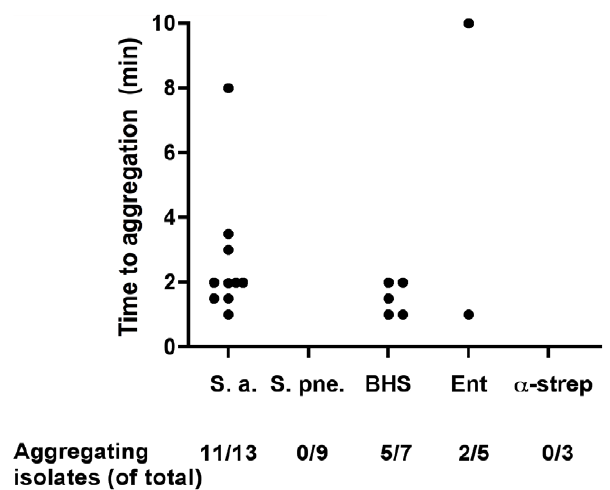
Figure 1. Platelet aggregation by Gram-positive pathogens. Time to aggregation of platelets in PRP from patients is shown. Filled circles depict aggregating isolates. Below the diagram are the numbers of aggregating isolates divided by the total number of isolates of the respective species presented. Abbreviations, which are used through- out the figures, are Staphylococcus aureus (S. a), Streptococcus pneumoniae (S. pne), beta-hemolytic streptococci (BHS), enterococci (Ent), and alpha-hemolytic streptococci ( a